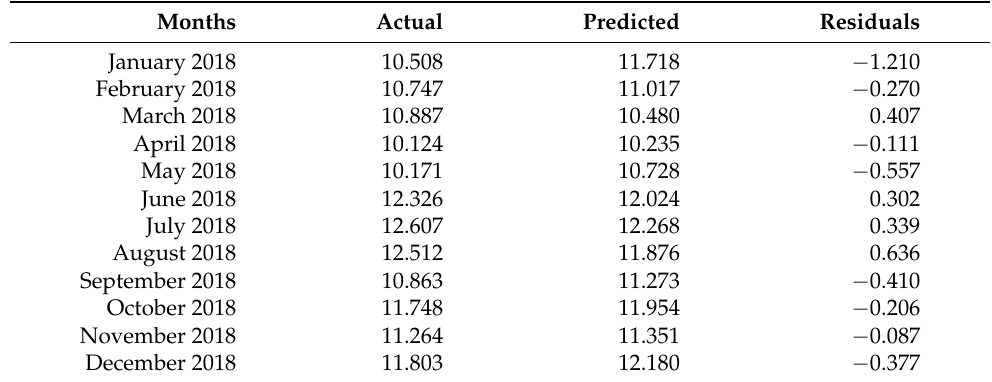
Figure 5. Time series plots showing the observed data EDH (red line) and modeled output (blue line) values for the model ARIMA(0,0,1) × (0,1,2) 12 . The forecast values for the year 2018 (green line) are shown with the 95% confidence intervals(shaded region). Table 2. Residuals of predicted and actual values of EDH for the model ARIMA(0,0,1) × (0,1,2) 12